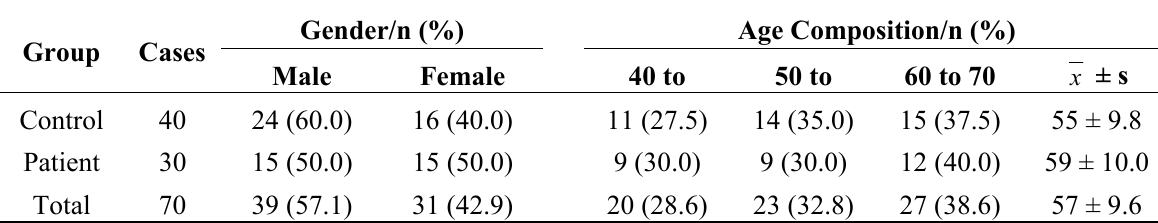
Table 2. Gender and age compositions of the patient and control